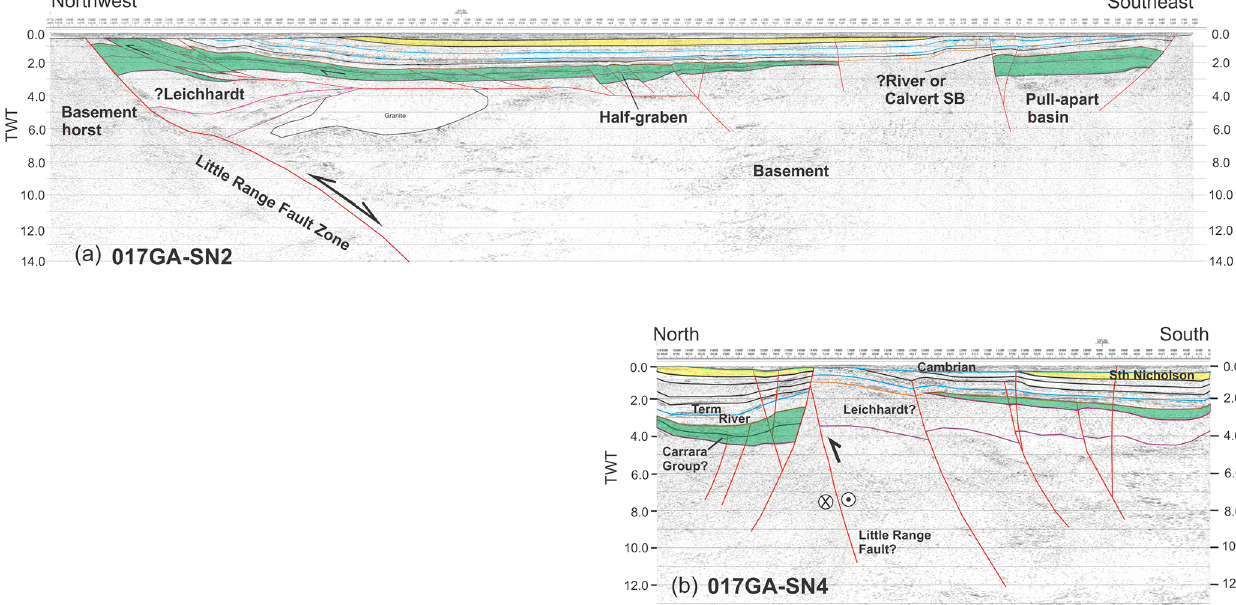
Figure 9. North–south-oriented seismic sections west of Lawn Hill Platform showing shallow crystalline basement and the same basement- rooted inversion structure. Note the major basement structure in (a) that cuts downward all the way to the MOHO is probably the same basement structure or fault zone (Little Range Fault Zone) imaged in (b) , over which all older sedimentary basins have been eroded so that rocks of Cambrian age (Georgina Basin) directly overlie basement (17GA–SN4). Rocks of the South Nicholson have similarly been removed for the crest of this basement block in 17GA–SN4 and, together with rocks of the Isa Superbasin, increase in thickness northwards. The Isa Superbasin is abruptly truncated by the basement structures and other subvertical structures suggestive of a flower structure and late-stage onset of strike-slip faulting at or before the deposition of the Cambrian Georgina